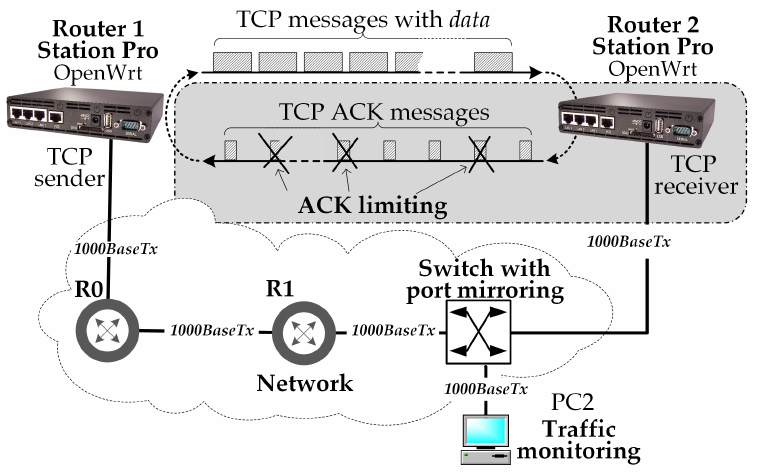
Figure 4. Test setup of transport control protocol (TCP) acknowledgment (ACK) rate limiting on physical